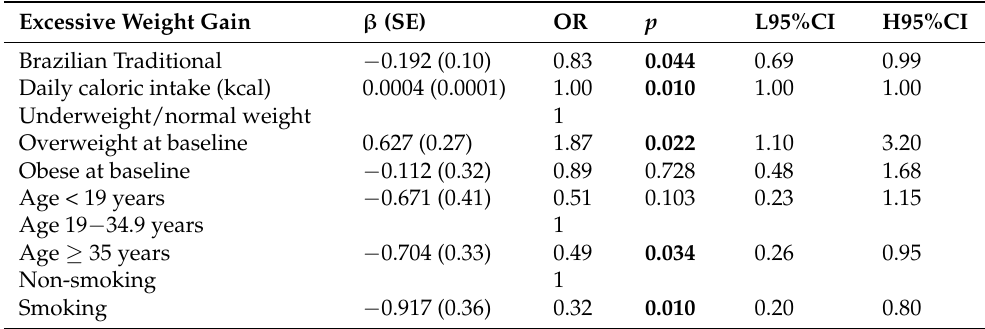
Table 4. Results of mixed-effects logistic regression relating EGWG to maternal characteristics and dietary pattern. ProcriAr, S ã o Paulo